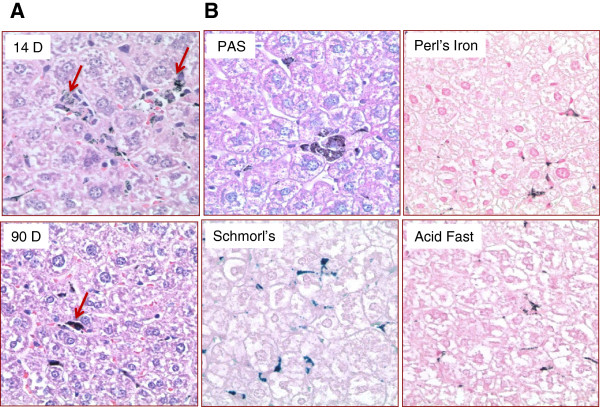
Liver pigment. A: Arrows point to pigment in both 14-day and 90-day liver tissues. The 14-day tissue has more Kupffer cells filled with pigment. The 90-day tissue has pigment but fewer Kupffer cells with pigment. B: Section of liver pigment stained with PAS, Perl’s iron, Schmorl’s, and acid fast. Schmorl's stain has some of the slightly blue reaction for lipofuscin, but the other lipofuscin stains (PAS, acid fast) do not have the characteristic color for lipofuscin. The Perl’s iron stain is negative for iron. Magnification: ×400.